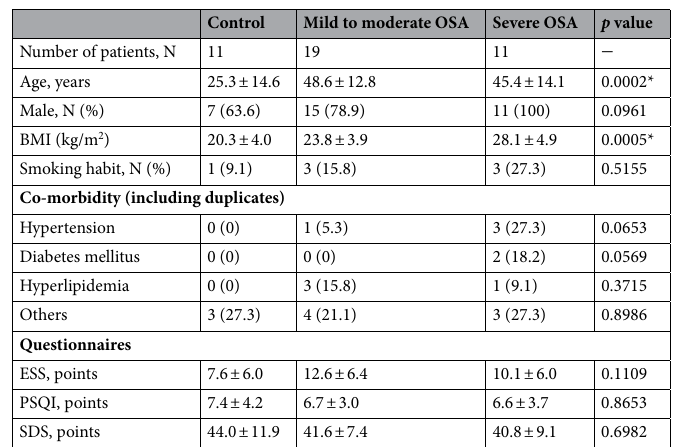
Table 1. Demographic characteristics and questionnaires. AHI, apnea-hypopnea index; BMI, body mass index; ESS, Epworth Sleepiness Scale; OSA, obstructive sleep apnea; PSQI, Pittsburgh Sleep Quality Index; SDS, Self-rating Depression Scale; *, p <